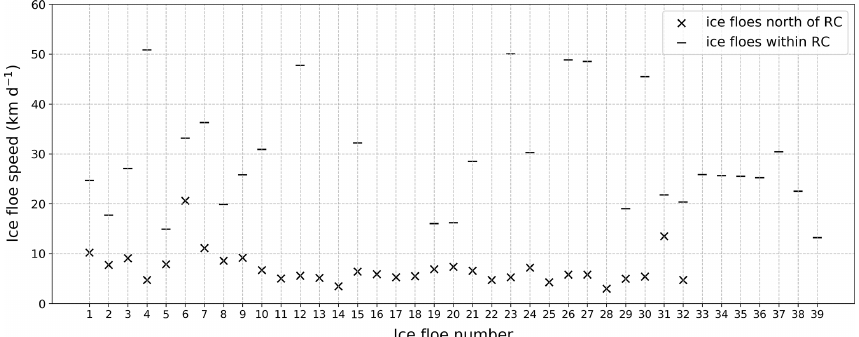
Figure 5. Average speed of individual ice floes during the periods upstream and within the Robeson Channel. The last seven floes (nos. 33– 39) drifted within the Robeson Channel with highly variable speeds.